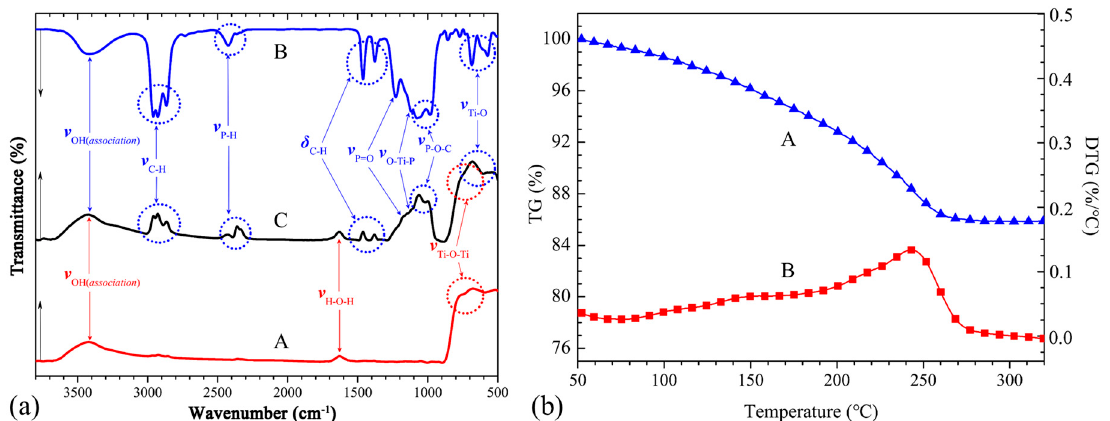
Figure 5. ( a ): FTIR spectra of pure nano-TiO 2 (A), tetraisopropyl di (dioctylphosphate) titanate (TDT) (B), and modified nano-TiO 2 (C), ( b ): TG (A) and derivative thermogravimetry (DTG) (B) of modified nano-TiO 2 under nitrogen with a heating rate of 10 °C per minute.